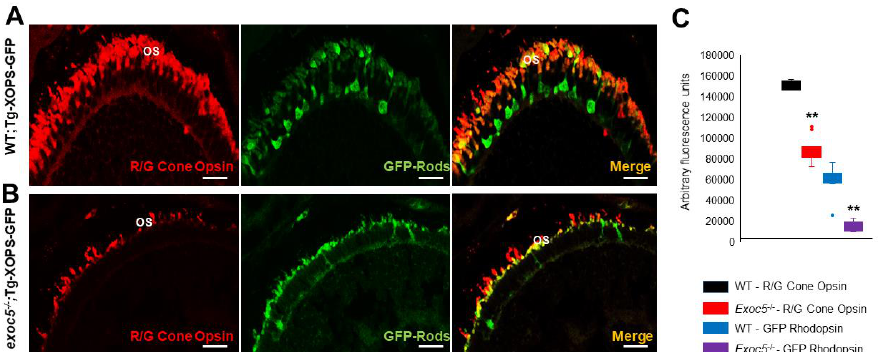
Figure 3. Immunohistochemical analysis of rod and cone photoreceptors in transgenic (Tg:XOPS) wild-type and exoc5 mutant zebrafish. Top panel: wild-type:Transgenic-XOPS (WT;Tg-XOPS-GFP) zebrafish retinas immunostained with R/G cone opsin (red). Bottom panel: exoc5 −/− mutant:Transgenic-XOPS ( exoc5 −/− ;Tg-XOPS-GFP) retinas immunostained with R/G cone opsin (red). The transgenic line expresses soluble endogenous GFP in rods (green). Significantly shorter rod and cone OS were observed in exoc5 −/− mutant zebrafish, compared to WT zebrafish, at similar ages. ( C ) Image J was used to quantify fluorescence for R/G cone opsin and GFP+ rods. ** p < 0.005 (WT vs. exoc5 −/− mutants). 2.3. RPE-Specific Ablation of Exoc5 in Mice Cause Retinal Cell Degeneration